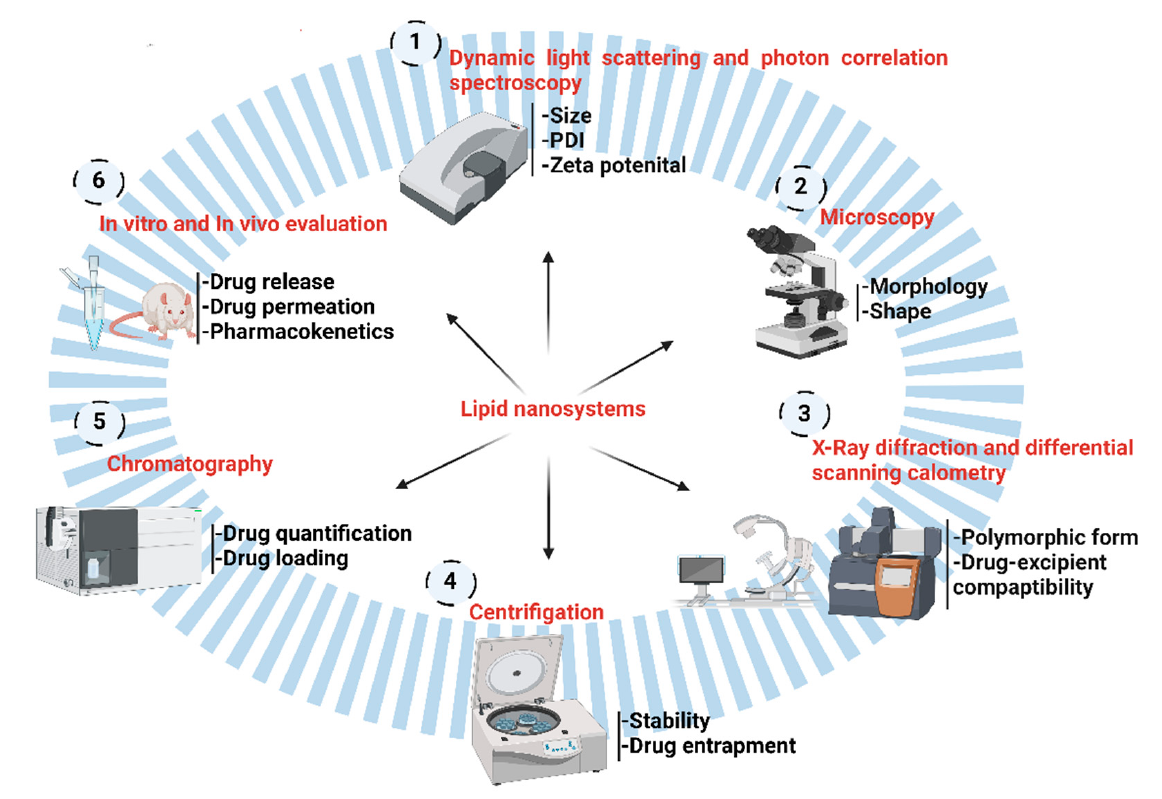
Figure 4. Common characterization and evaluation techniques of lipid nanosystems .